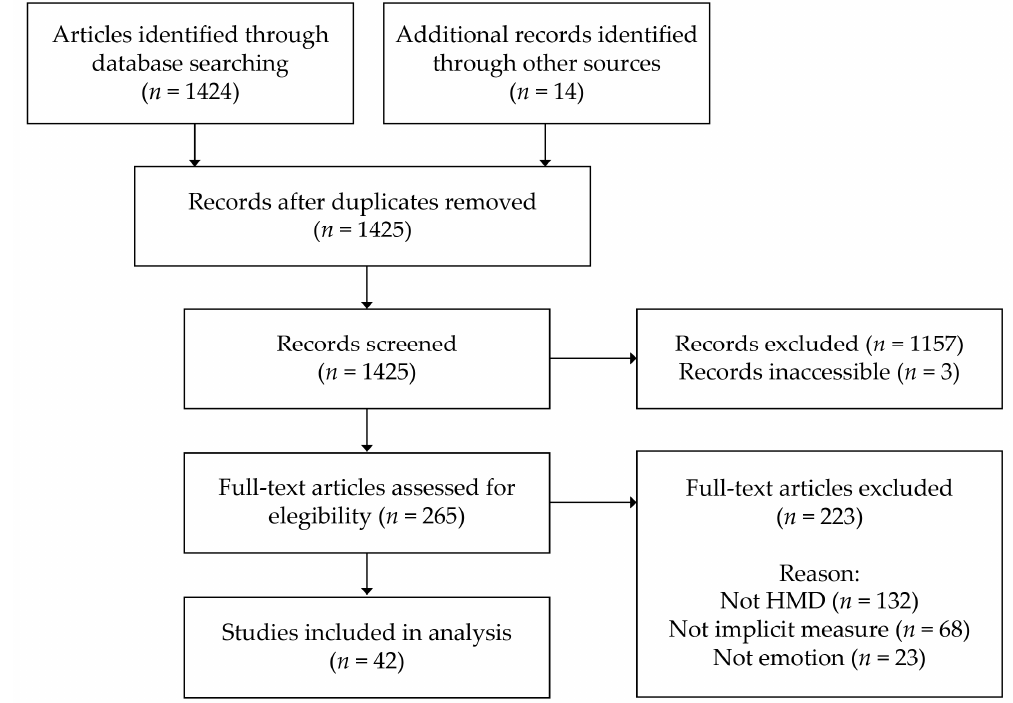
Figure 1. Scheme of the PRISMA procedure followed in the review.